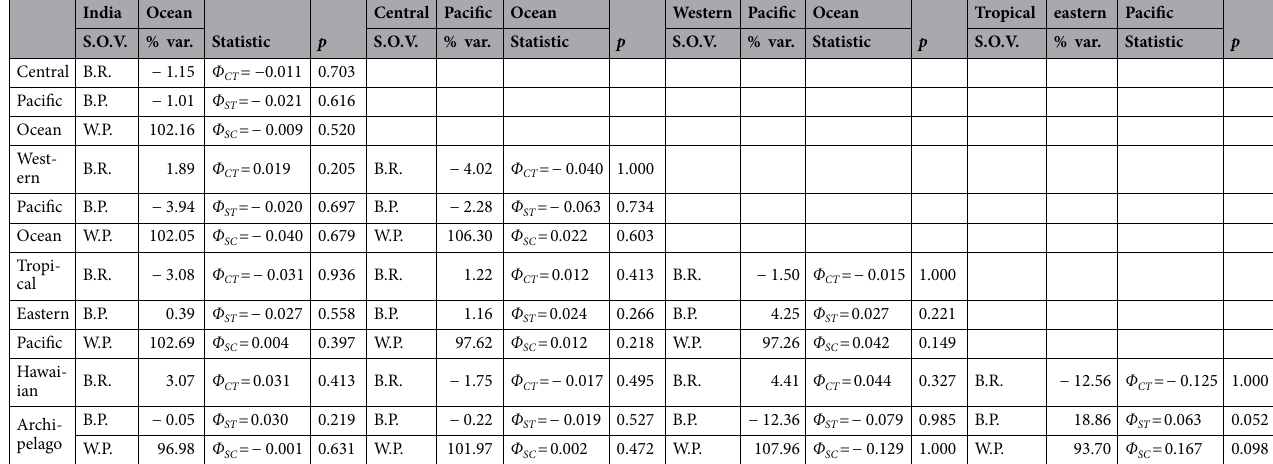
Table 7. Between region pairwise AMOVA of nDNA Tamura and Nei 31 distances in Echinothrix diadema. S.O.V. source of variation, B.R. between regions, B.P. between populations within regions, W.P. within populations, % var . percentage of variation. n.b. Tropical eastern pacific = Clipperton Island + Isla del Coco.